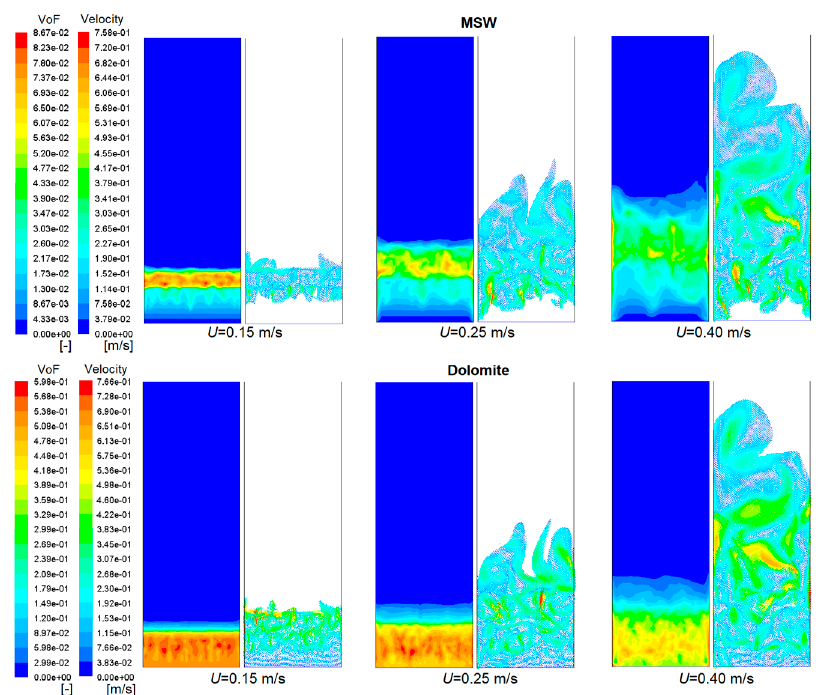
Figure 7. Pairs of time-mean solids volume fractions distributions (left) compared alongside with instantaneous solids velocity vector distributions (right) at three different superficial gas velocities (0.15, 0.25 and 0.40 m/s). MSW particle size 5 mm, operating temperature 873 K and simulation time 3 s.